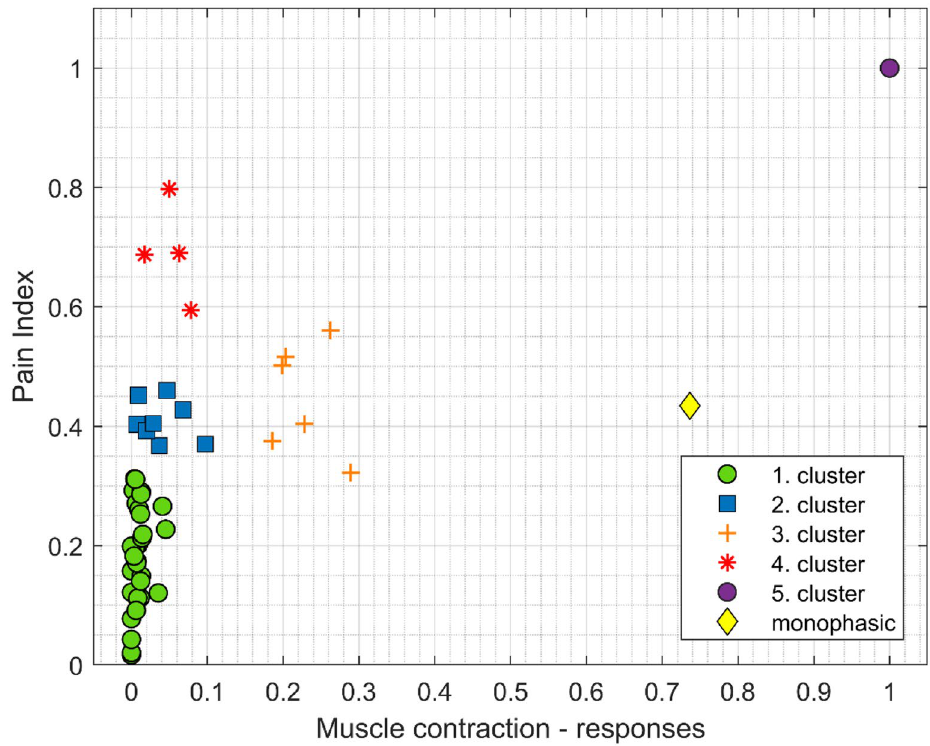
Figure 3. Clustering based on a hierarchical cluster tree (dendrogram). Each mark represents one pulse protocol: x—muscle contraction response, y—pain index. The data shown is normalized based on the purple cluster (T p = 5 µs, d 1 = 100 µs, d 2 = 100 µs). Note that the yellow diamond represents the amplitude determining (reference) protocol (8 monophasic pulses × 100 µs, 5 kHz) with 2.5 lower